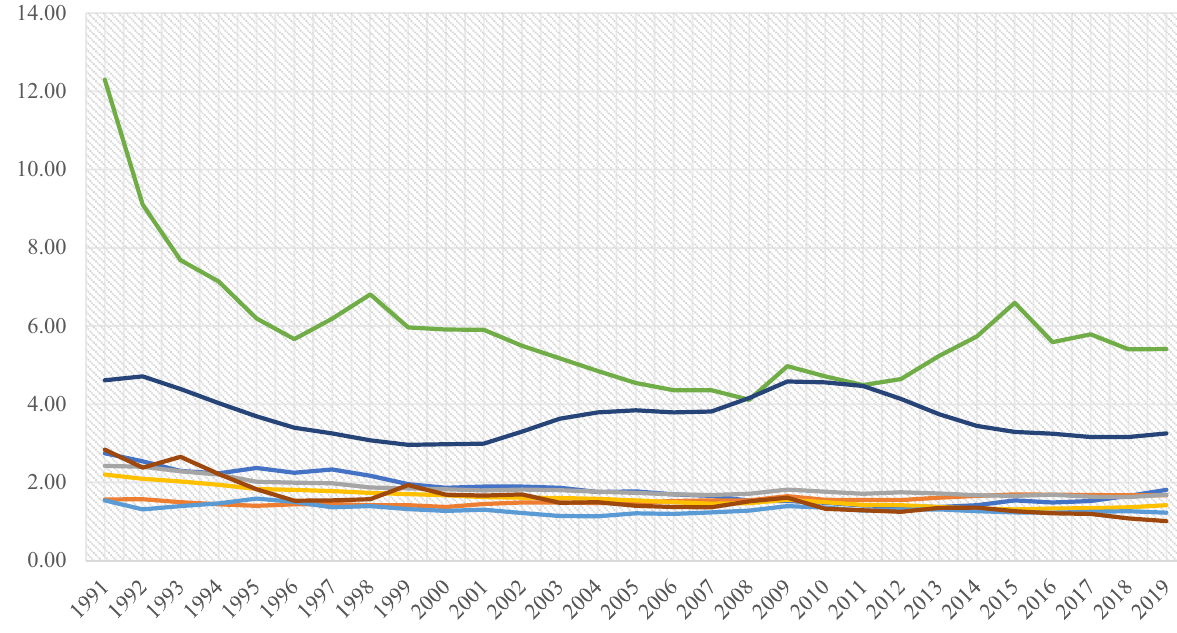
Fig. 14 Trend of regional military expenditure (1991–2019)